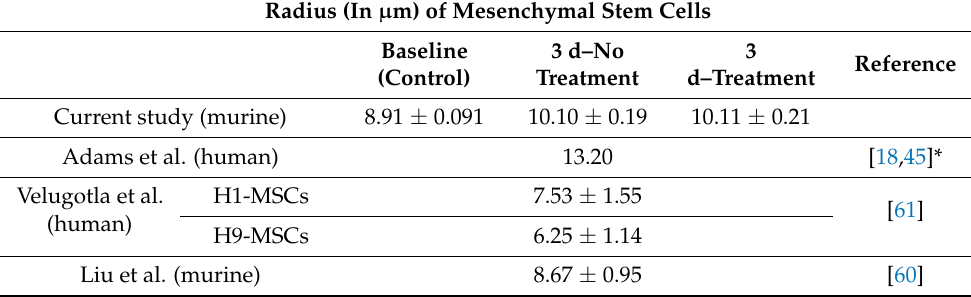
Table 2. Various studies reporting sizes of MSCs derived from different sources.